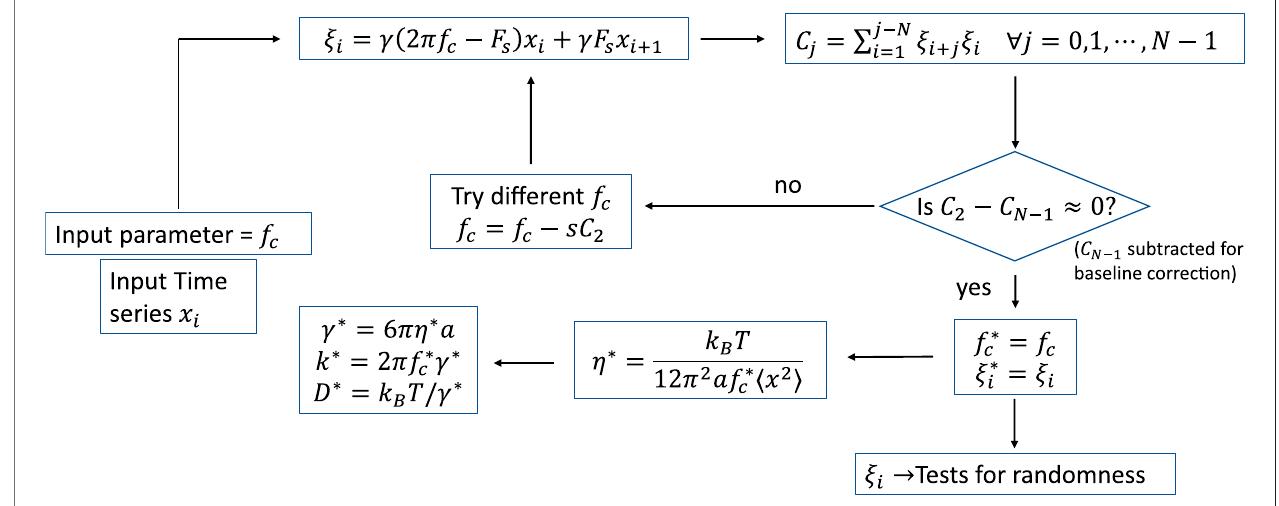
FIGURE 1 | Schematic of our algorithm for trap parameter extraction and random number